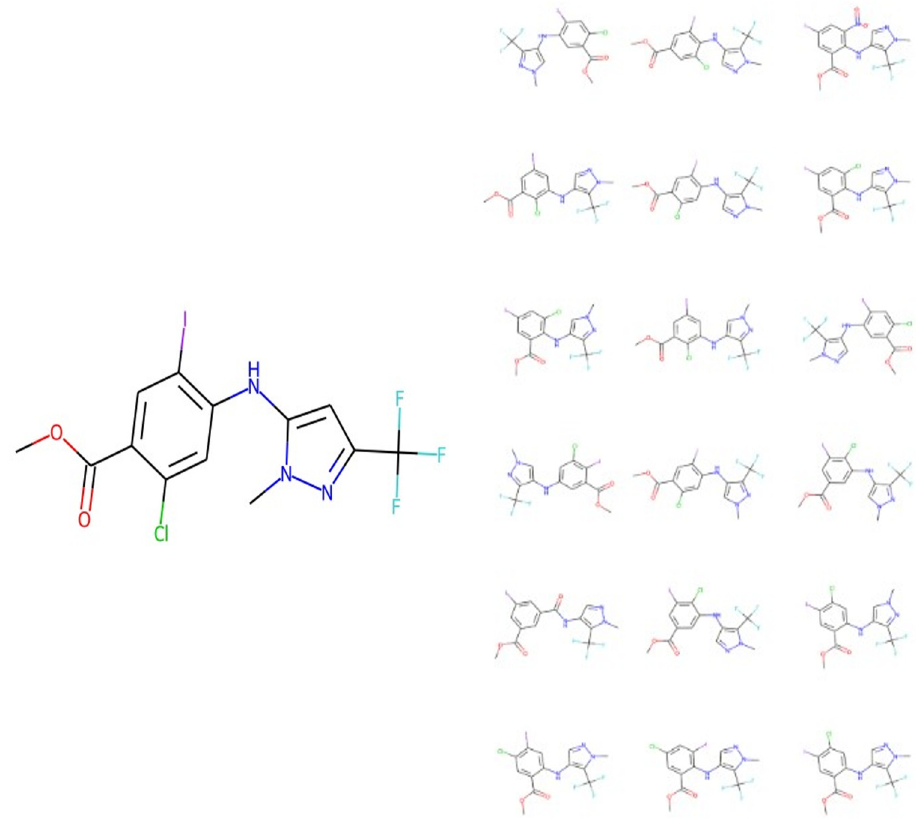
Figure 2. Illustration of the means by which MassGenie can predict a series of candidate molecules. In this case, the ‘true’ molecule is shown on the left, and 18 candidate molecules (from 100 runs) shown on the right. It is clear that all are close isomers, containing a methoxybenzoate moiety linked via a secondary amine to a pyrazole ring with a trifluoromethyl substituent.